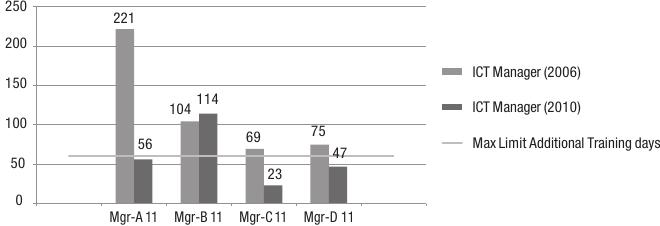
Fig. 7. Gap between the requirements of economic entities on knowledge and the knowledge offered by university graduates Source: